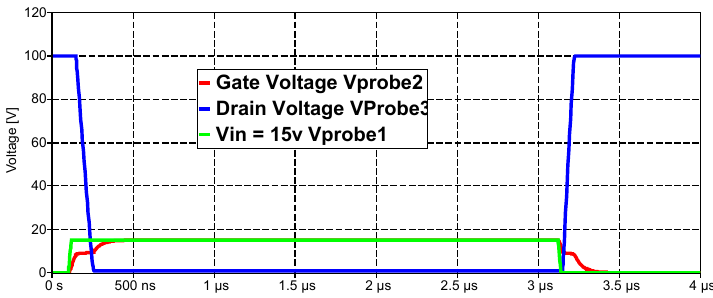
Figure 16. RMOS0101D with resistive load (Figure 15).